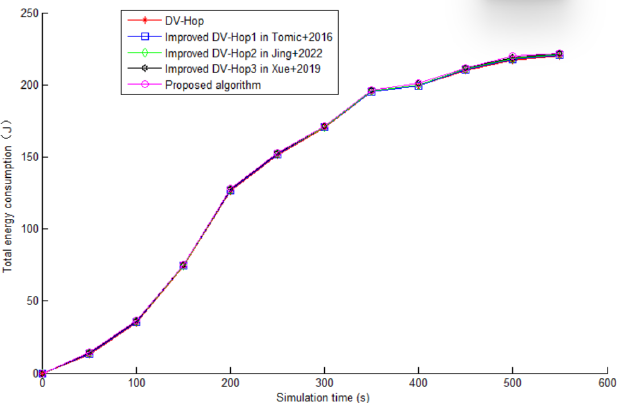
Figure 12. Comparison of energy utilization efficiency[21][22][23].